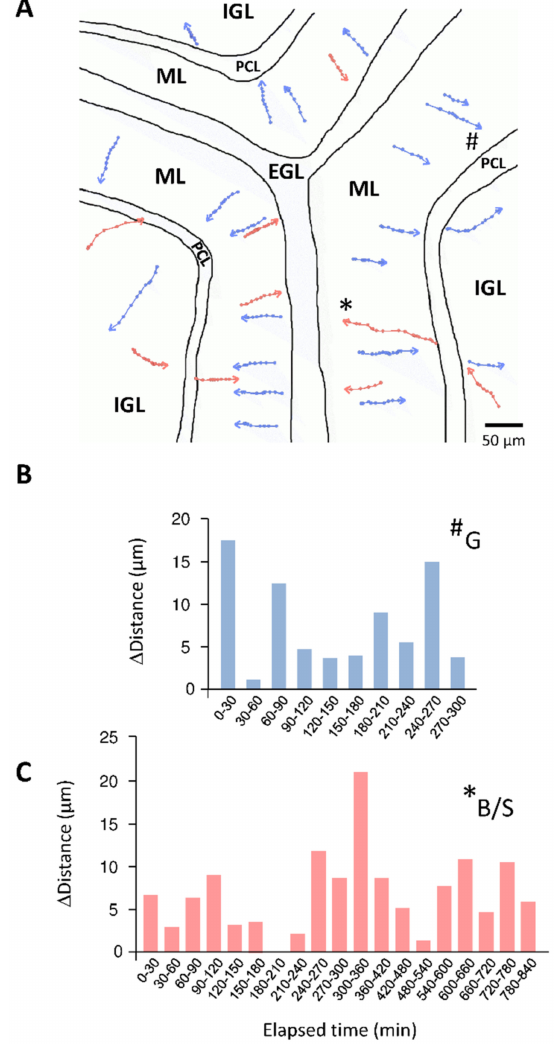
Figure 4. Illustration of the concomitant migration of granule and basket/stellate cells in the postnatal cerebellum through confocal macroscopy. ( A ) Tracking of centripetal migration (towards the bottom of the IGL) of granule cells (blue) and centrifugal migration (towards the top of ML) of basket/stellate cells (pink). ( B ) Saltatory movements of a granule cell (marked as # in ( A )) in the ML. ( C ) Saltatory movements of a basket/stellate cell (marked as * in ( A )) in the ML. EGL, external granular layer; ML, molecular layer; PCL, Purkinje cell layer; IGL, internal granular